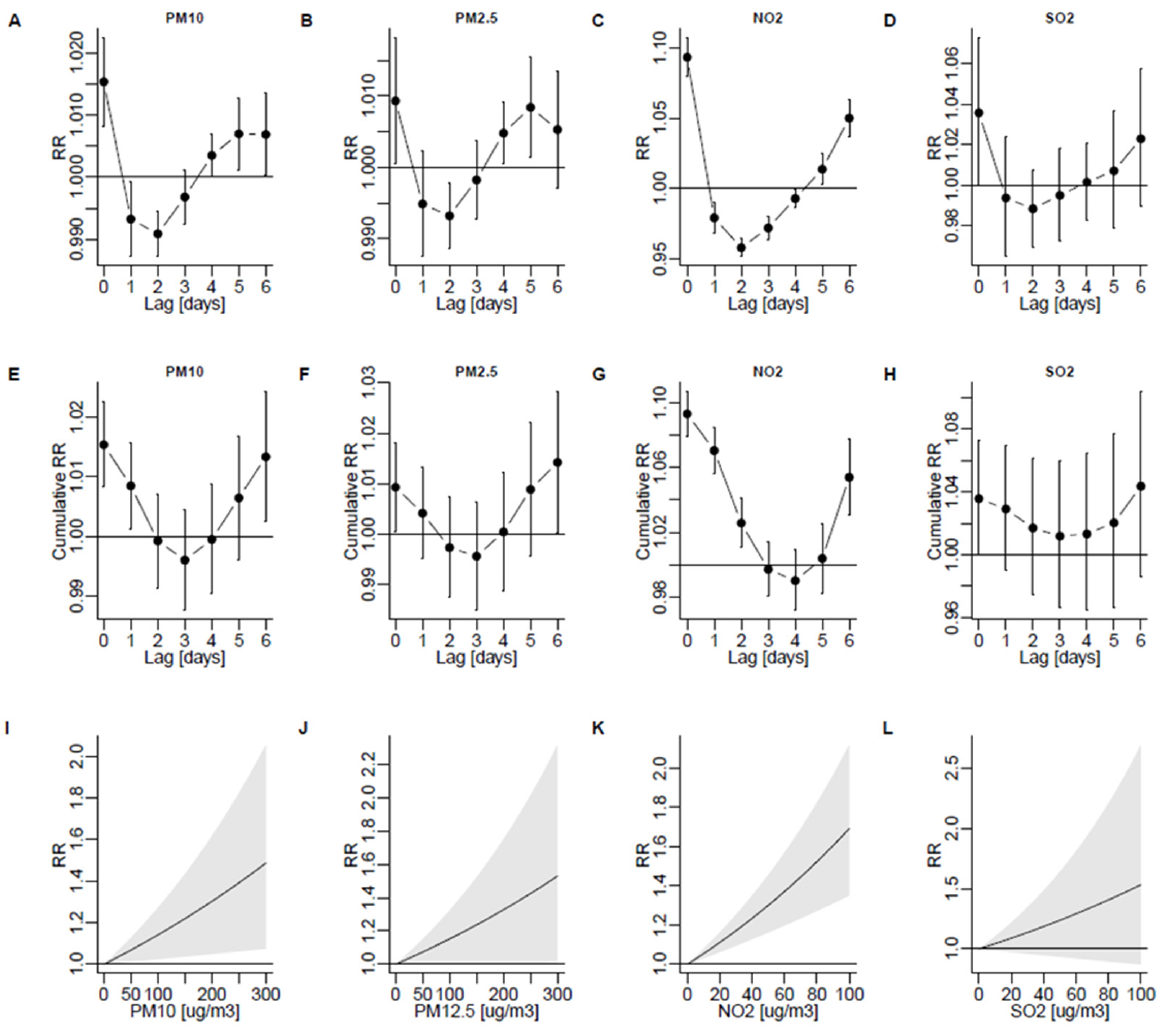
Figure 2. Risk of admission due to J45 or J46 (“asthma”) per 10 µ g/m 3 for PM 10 ( A ), PM 2.5 ( B ) NO 2 ( C ), and SO 2 ( D ) depending on lag. Cumulative effects are shown in ( E – H ). Predicted admission risk within a range of exposure is shown in ( I – L ). 95% confidence intervals are shown as bars ( A – F ) or shaded areas ( G – I ). RR, rate ratio.